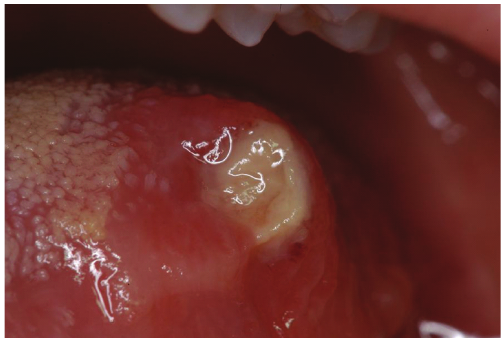
Figure 1: Ulceration of tongue.